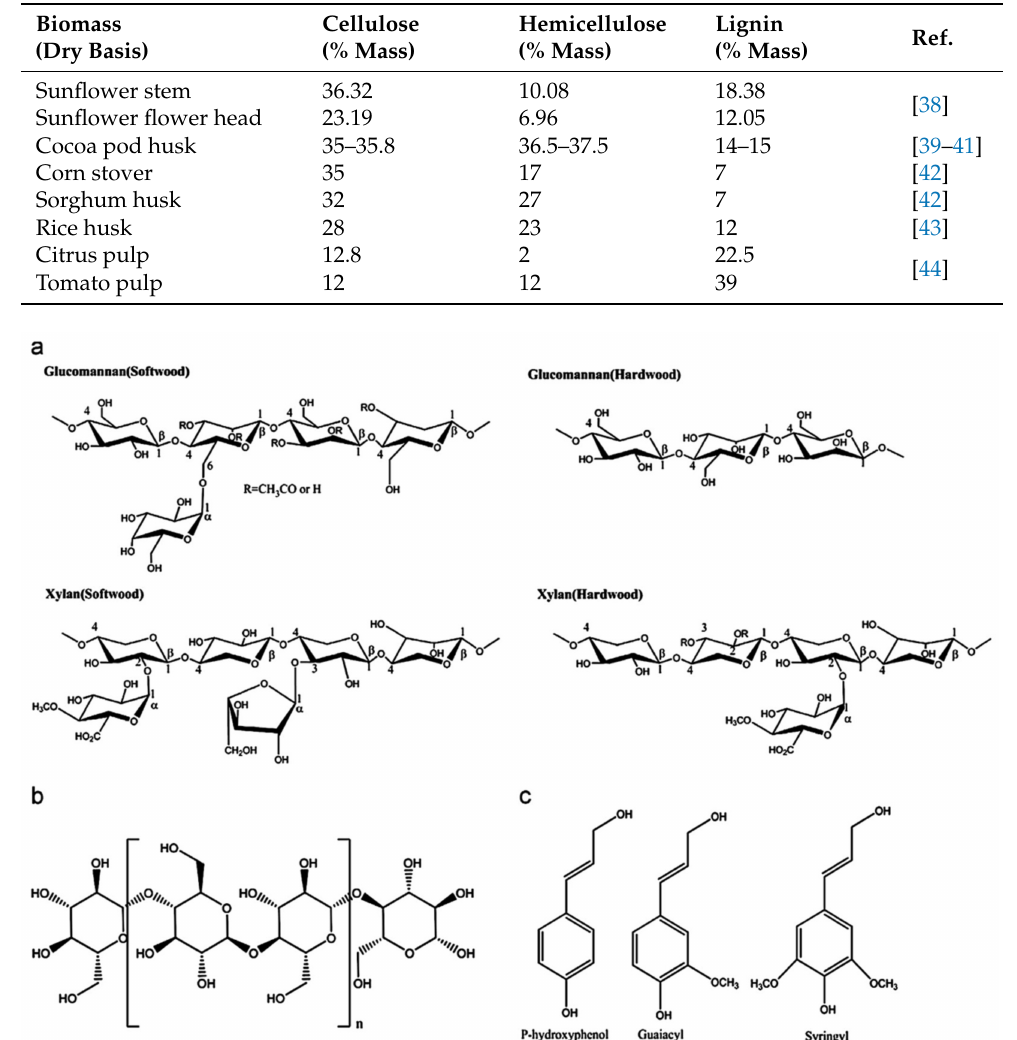
Figure 2. Schematic structure of: ( a ) hemicellulose, ( b ) cellulose, and ( c ) lignin-forming units. “Reprinted with permission from [35]. 2016,